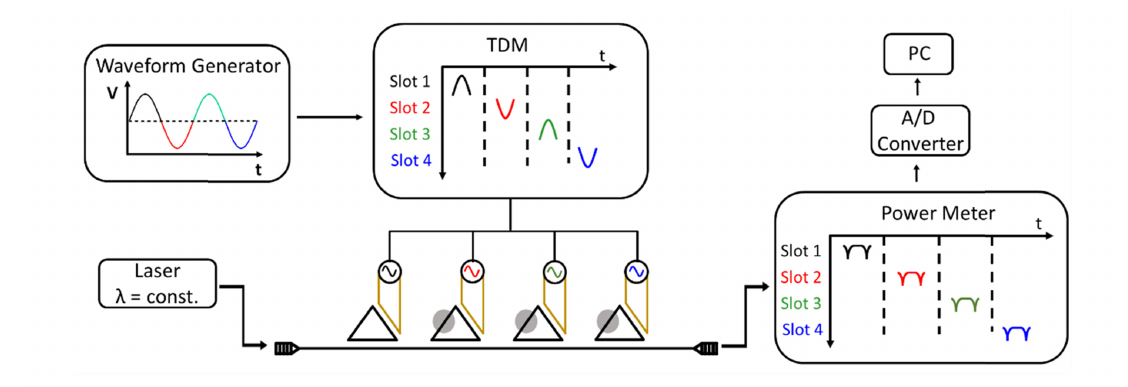
Figure 8. Schematic of ring resonator array. Each ring is separately addressed in the electronic regime to individually measure the transmission. The sinusoidal input signal is divided in certain time slots. Adopted from Ref.